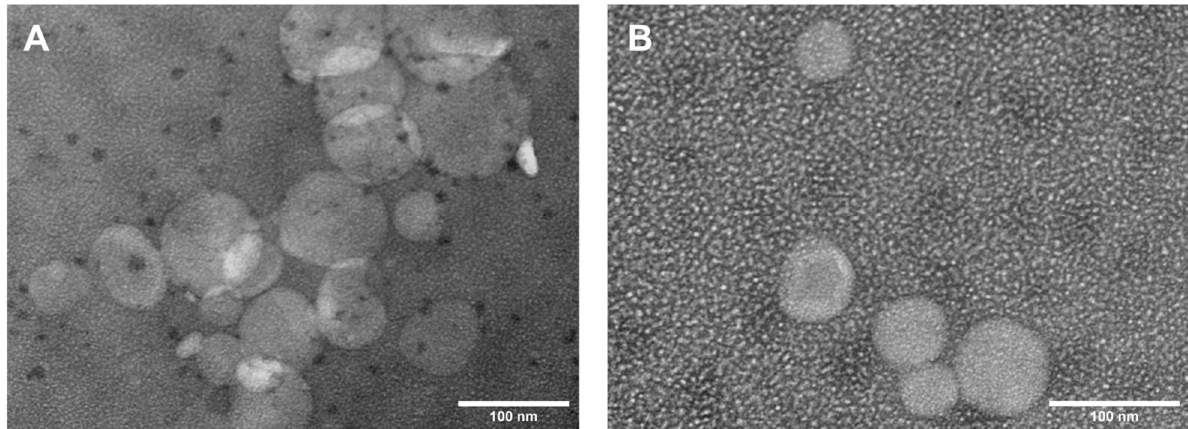
Figure 3. TEM images of blank liposomes ( A ) and sorafenib-functionalized liposomes ( B ).